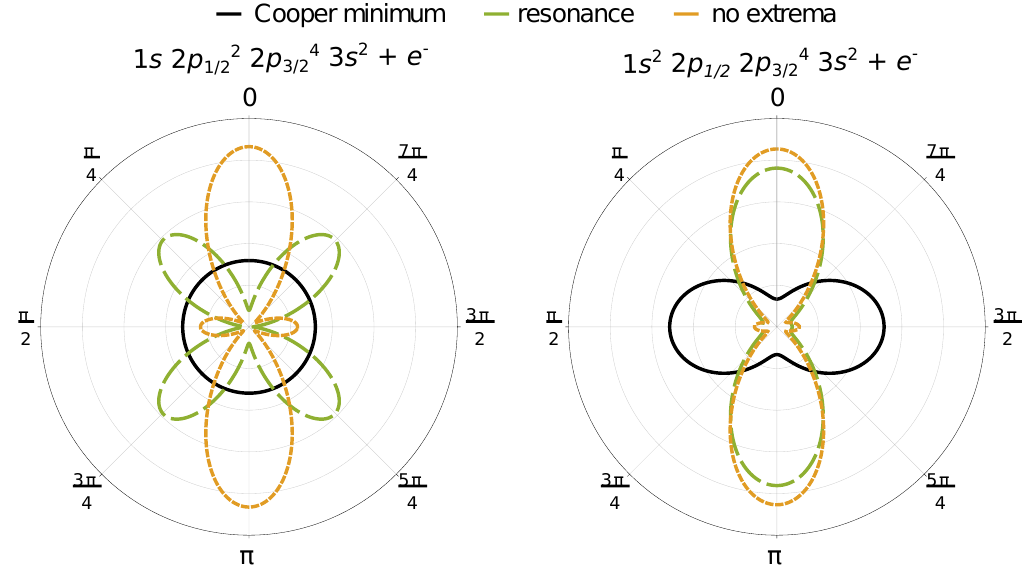
Figure 3. Photoelectron angular distributions of two-photon ionization of 1 s ( left ) and 2 p 1 / 2 ( right ) electrons of neutral magnesium atoms by linearly polarized light. The distributions were normalized to the total cross section. For ionization of each shell, distributions corresponding to three different photon energies are presented. Incident photon energy matching either the nonlinear Cooper minimum in solid black (1.288 keV and 55.88 eV for ionization of 1 s and 2 p 1 / 2 electrons, respectively), an intermediate level resonance (2 p 1 / 2 and 3 d for ionization of 1 s and 2 p 1 / 2 electrons, respectively) in long-dashed green (1.256 keV and 55.835 eV) or an energy, which does not match either extrema in short-dashed orange (1.260 keV and 54.50 eV). From the plot, it can be clearly seen that the photoelectron angular distributions at the nonlinear Cooper minima are always